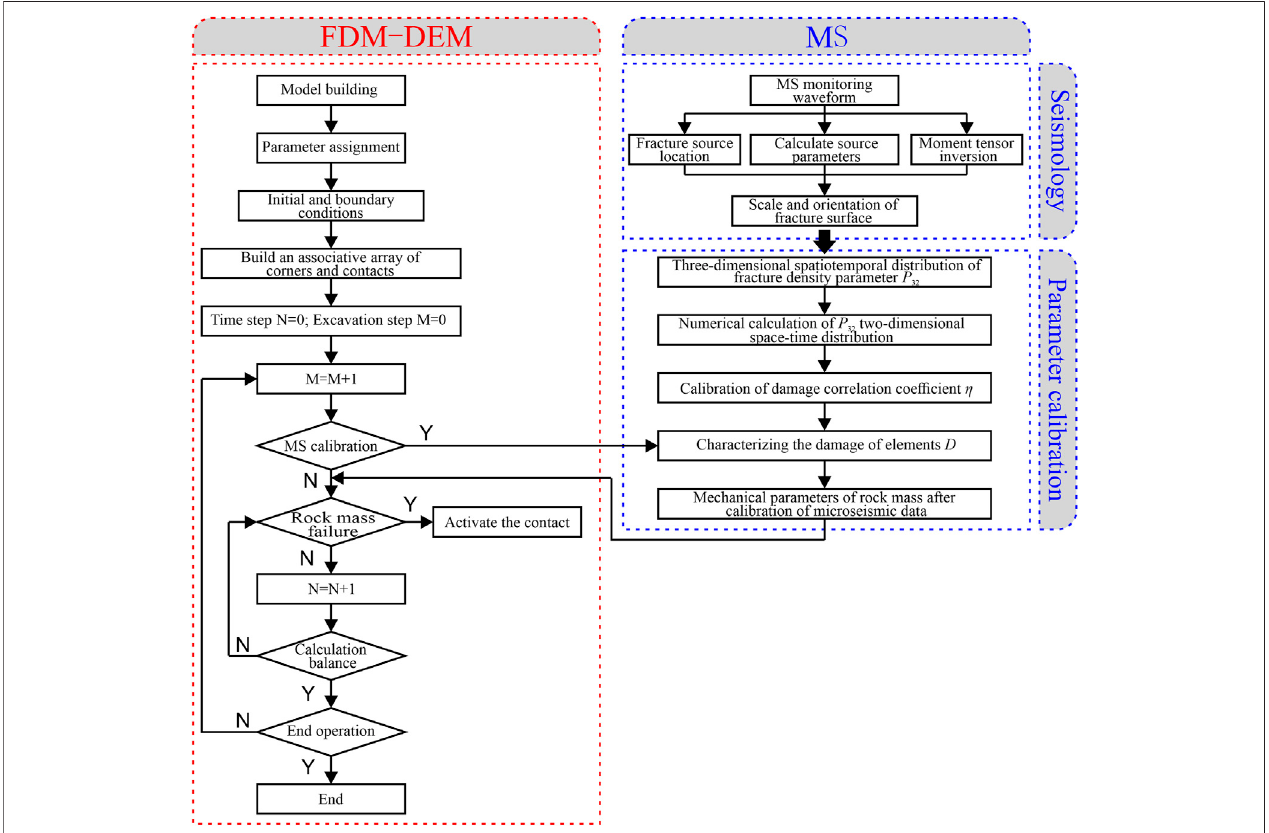
FIGURE 5 | Characterization fl ow chart of water inrush channel formation